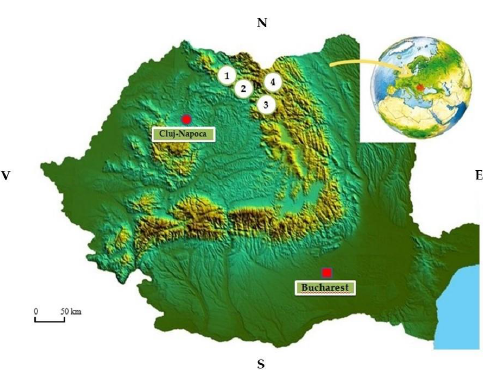
Figure 1. Romanian provenances of Picea abies seeds: 1 —P1 (Măria Mică), 2— P2 ( Făina), 3— P3 (Al- uniș), 4—P4 (Putnișoara) .